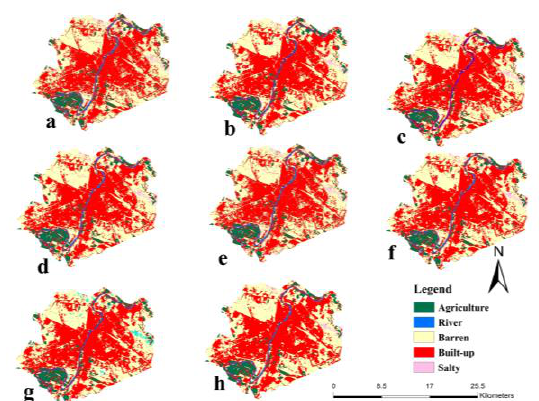
Figure 4. land-use simulation result of 2015 using rectangular spatial filter: (a) 3*3, (b) 5*5, (c) 7*7, (d) 9*9, (e) 11*11, (f) 13*13. (g) 15*15, and (h) 17*17.